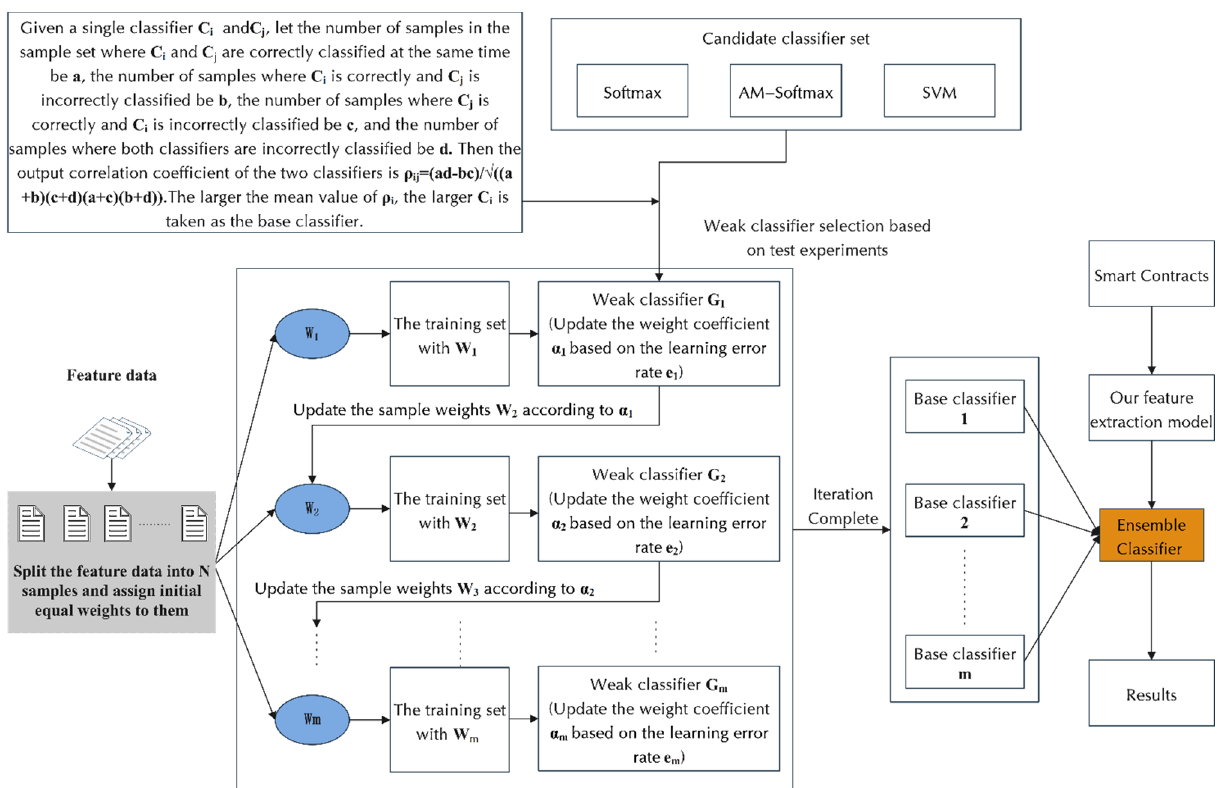
Figure 6. Structure diagram of the Ensemble Classifier.